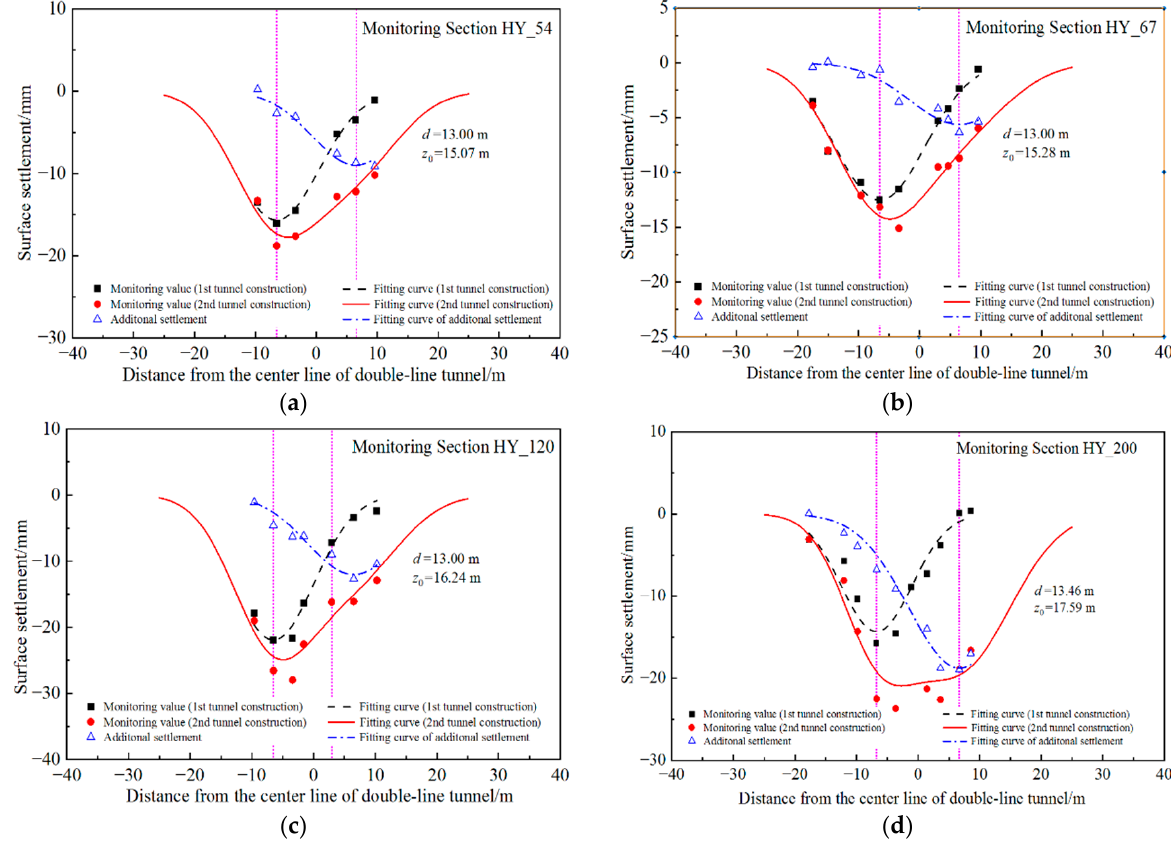
Figure 4. Settlement fitting curves of monitoring sections. ( a ) Monitoring section HY-54. ( b ) Monitoring section HY-67. ( c ) Monitoring section HY-120. ( d ) Monitoring section HY-200.